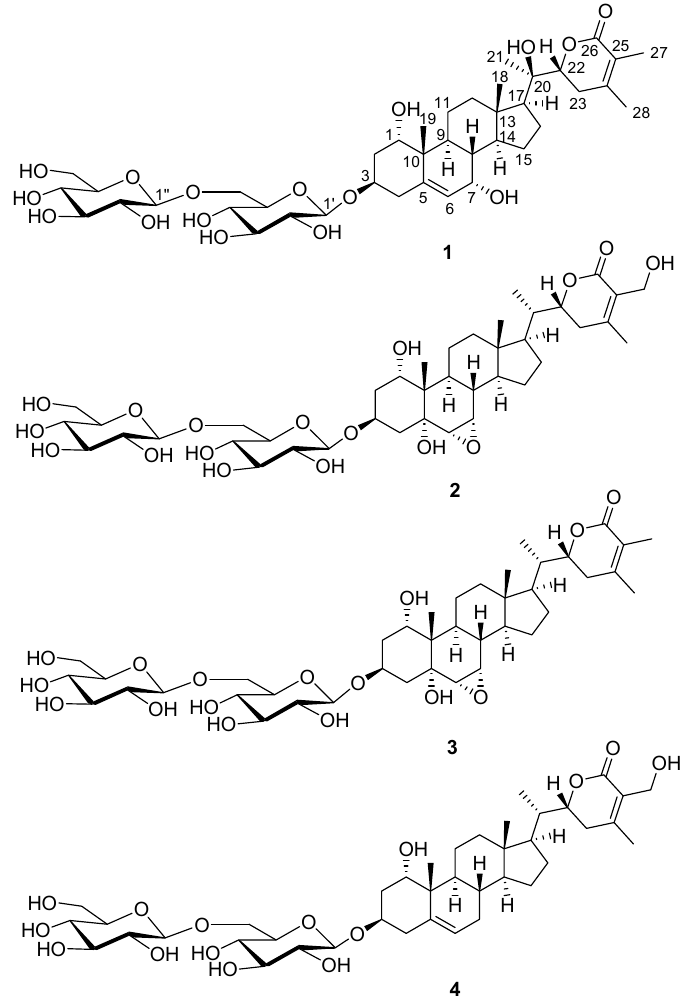
Figure 2. Chemical structures of compounds 1 – 4 . Table 1. 1 H (850 MHz) and 13 C NMR (212.5 MHz) data of compounds 1 and 1a in CD 3 OD ( δ in ppm) a .